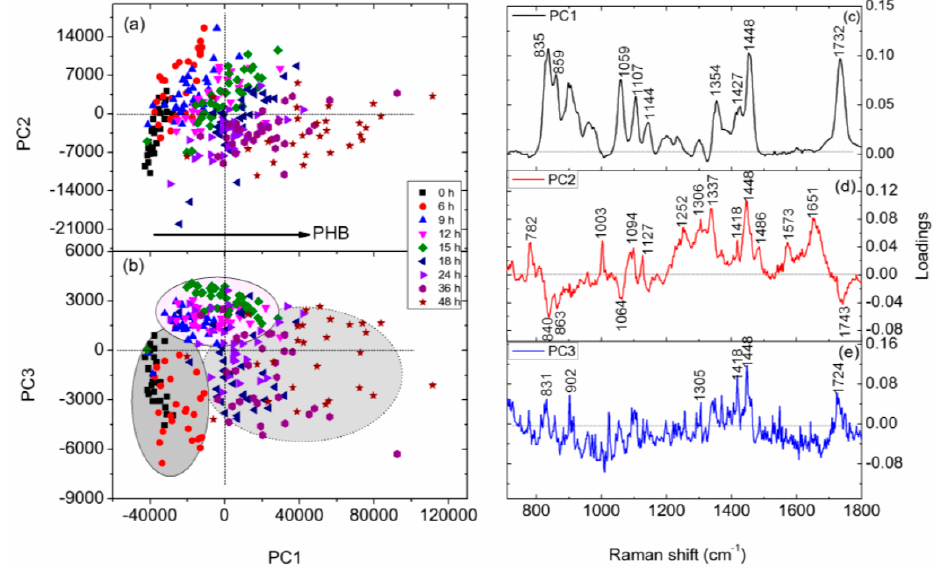
Figure 6. Principal components analysis (PCA) of Raman spectra of individual H16 cells at different culture time. ( a , b ) Scatter plots of PCA scores; ( c – e ) loadings of PC1, PC2, and PC3, respectively.